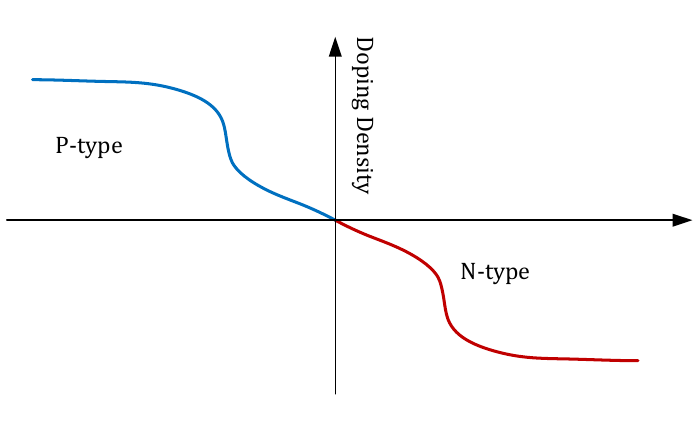
Figure 2. PN-junction doping profile of step recovery diode.